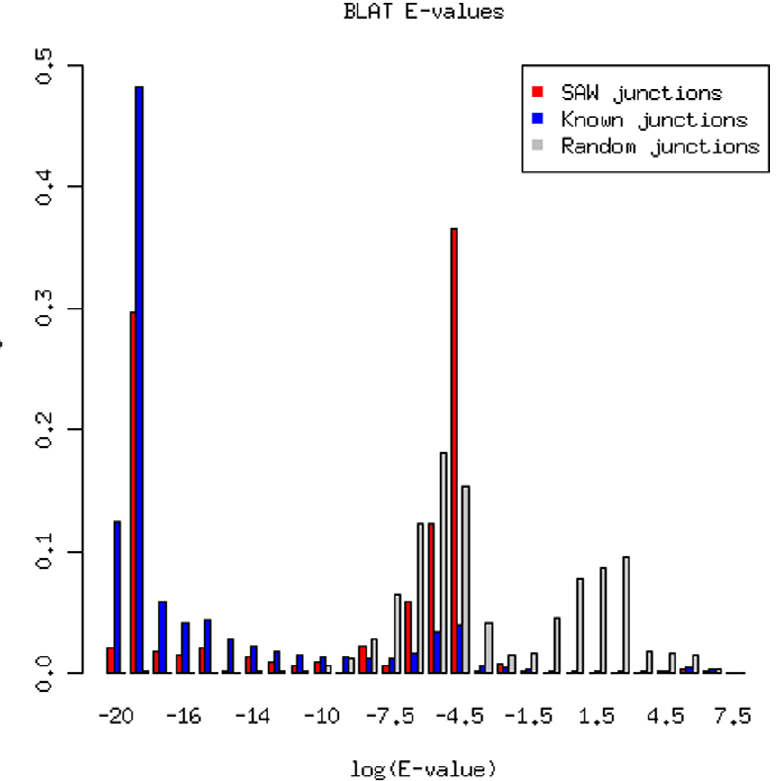
Figure 5. The BLAT E-value distribution of 48mers that spanning known junctions, random junctions and junctions identified by SAW.